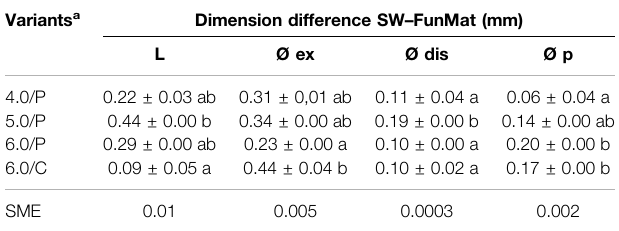
TABLE 7 | Designed (SW) and printed (FunMat) dimensions differences of the tibiae endoprosthesis ’ PEEK plug. Variants